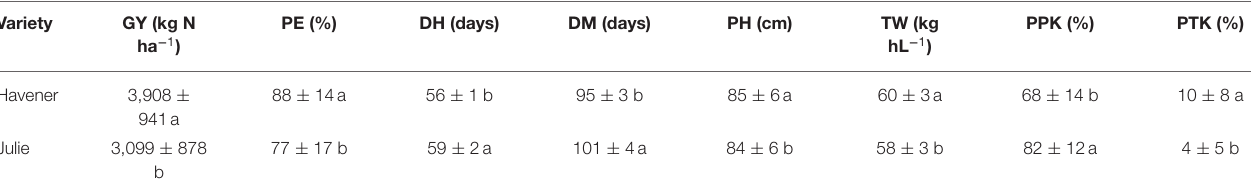
TABLE 9 | Barley varietal differences in yield and grain quality across all N treatments, locations and years.